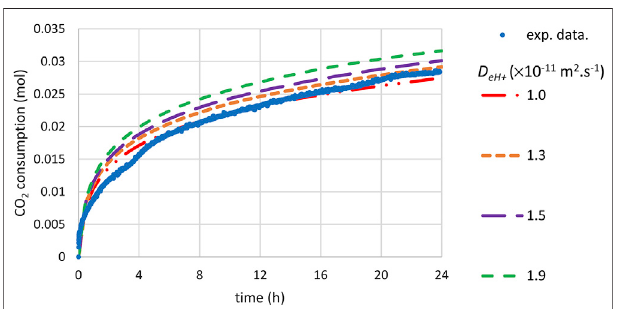
FIGURE 11 | Time-CO 2 consumption during slag carbonation (T (cid:2) 180 ° C, P CO2 (cid:2) 20 bar) following a preliminary attrition step under inert atmosphere and room temperature with stainless steel beads: comparison of experimental data and shrinking core model incorporating the PSD after grinding (see Figure 3 ).